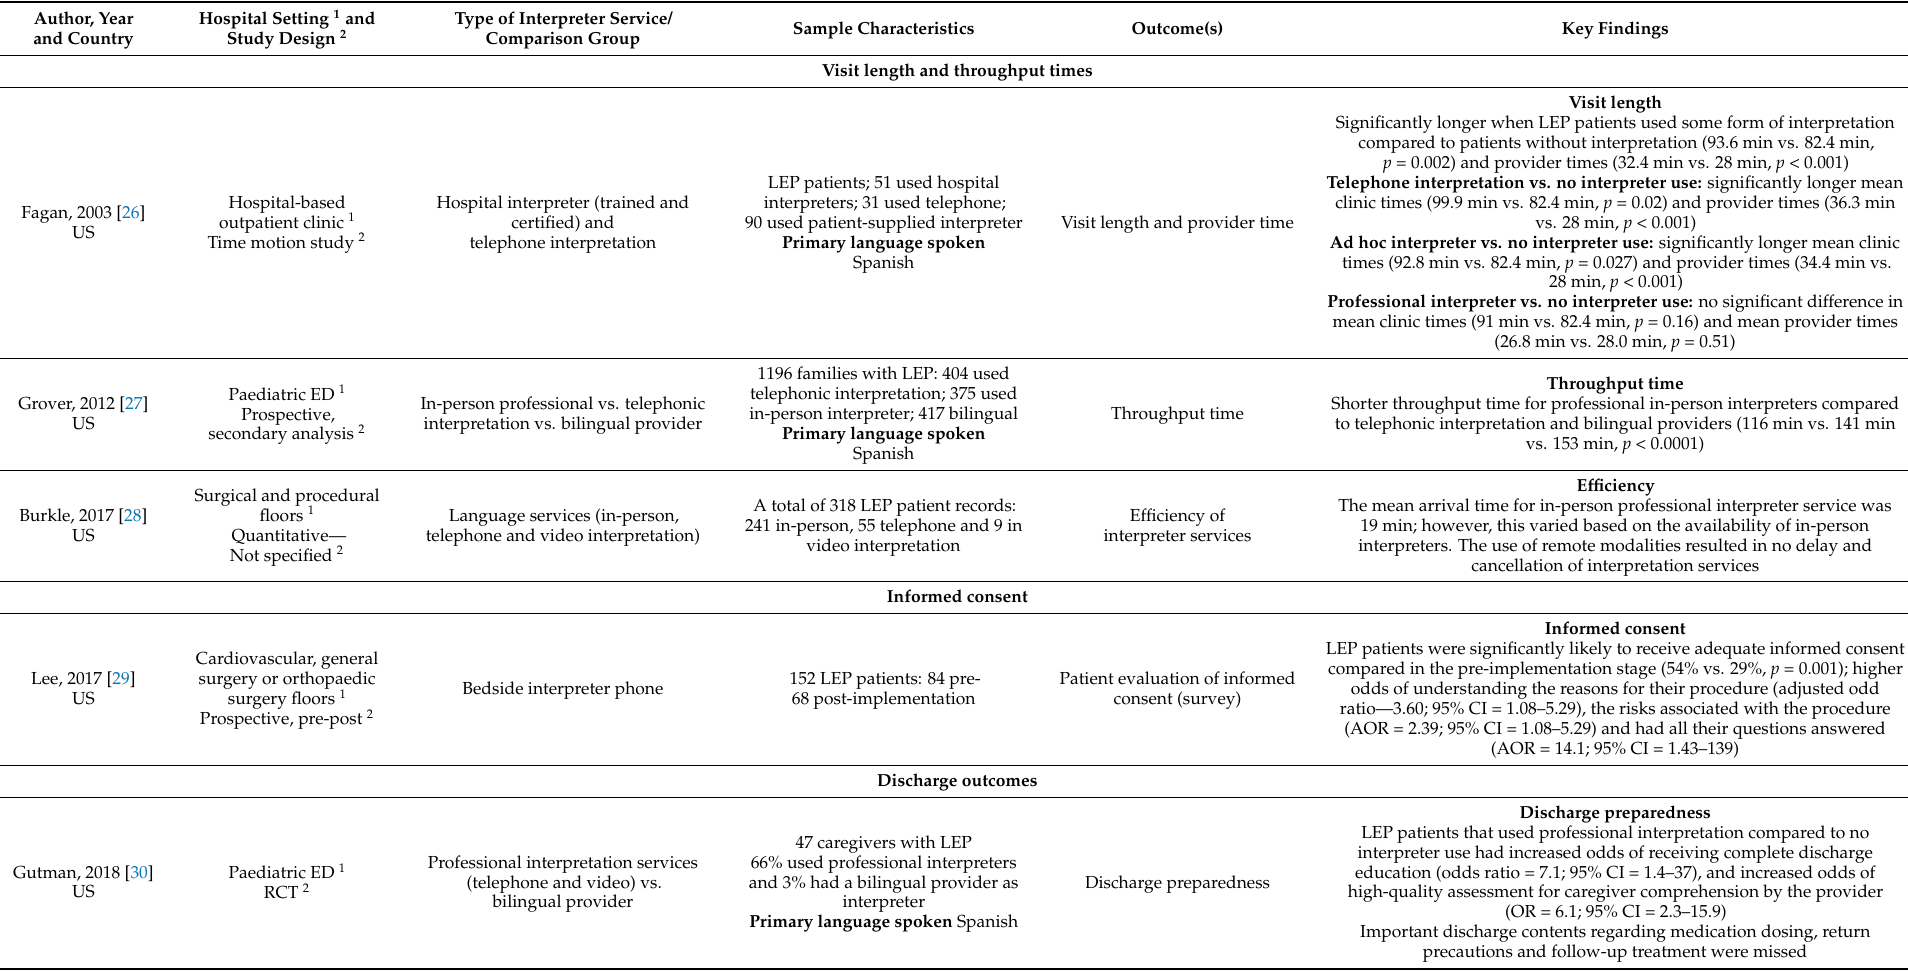
Table 4. Summary of studies that examine the impact on hospital care